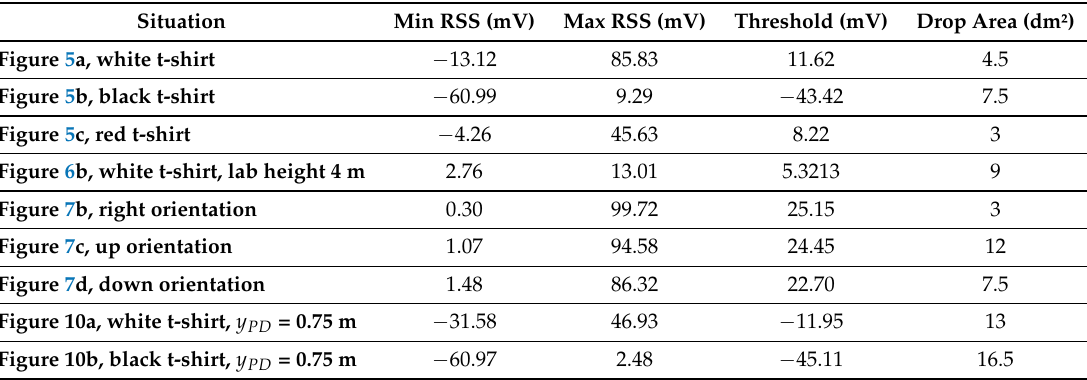
Table 1. Overview of statistics for all results.